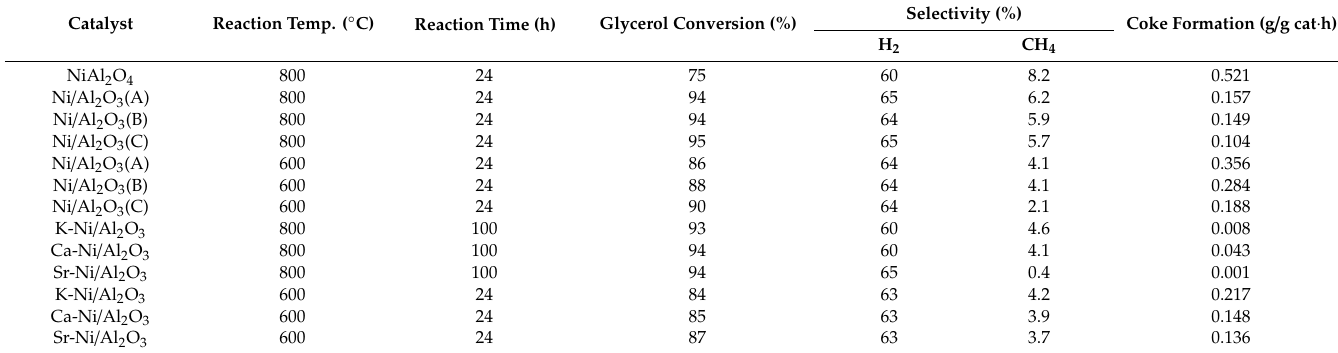
Table 5. The results of catalytic performance test for the SR of glycerol over the prepared Ni-based catalysts. A, B, and C stand for calcination temperatures of 750, 850, and 950 ◦ C, respectively [83] (used with copyright